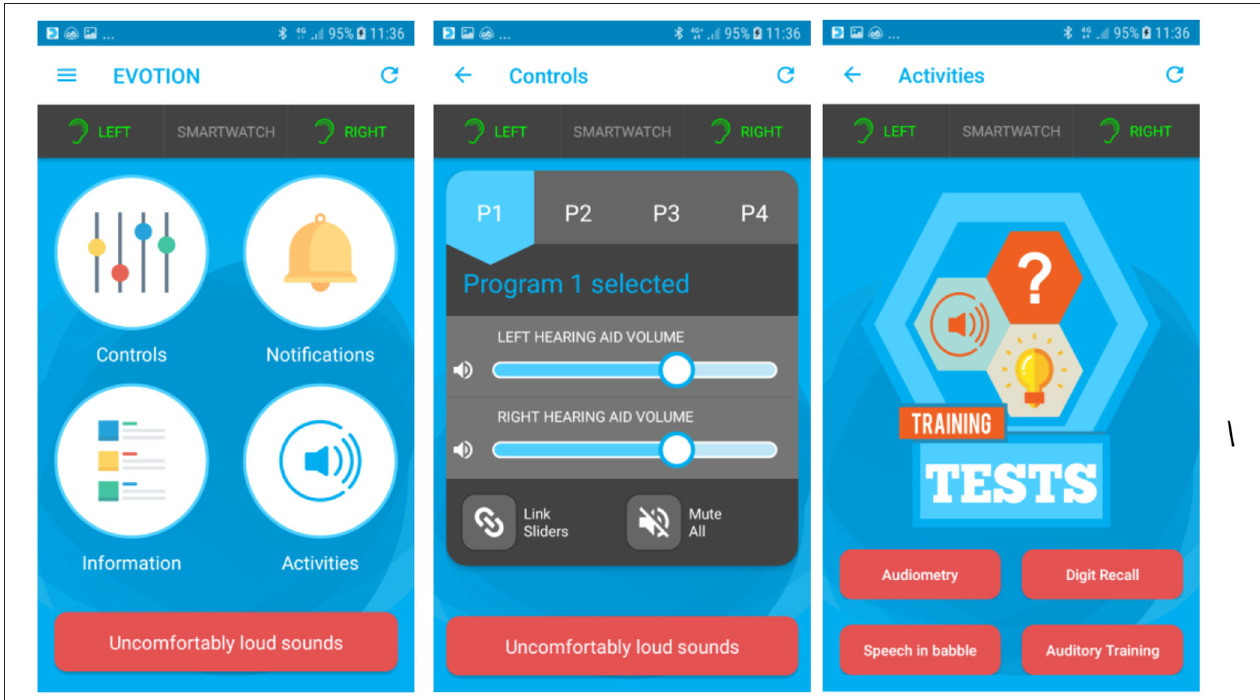
FIGURE 1 | EVOTION mobile app screens: Left panel shows all available functions. Middle panel shows the hearing aid controls. Right panel shows the four available tests and